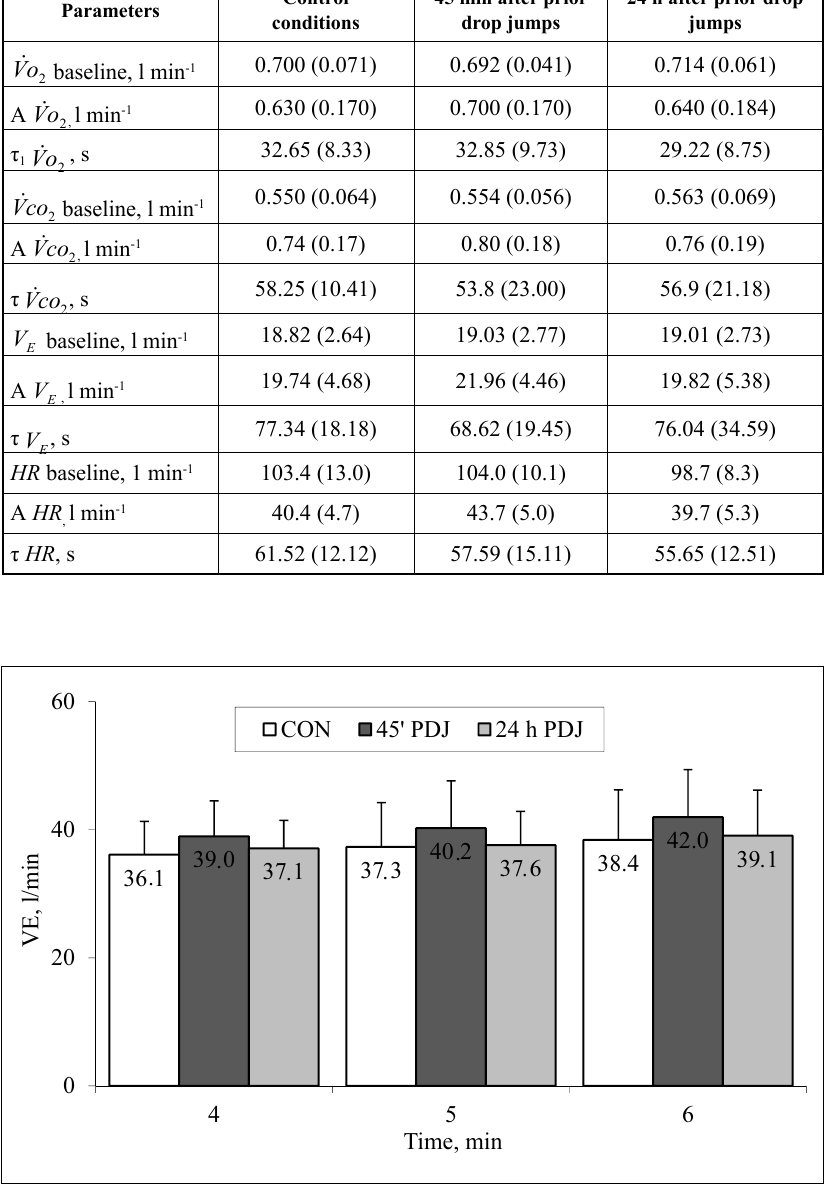
Figure 2. Group mean response of pulmonary ventilation ( V E ) during moderate cycling